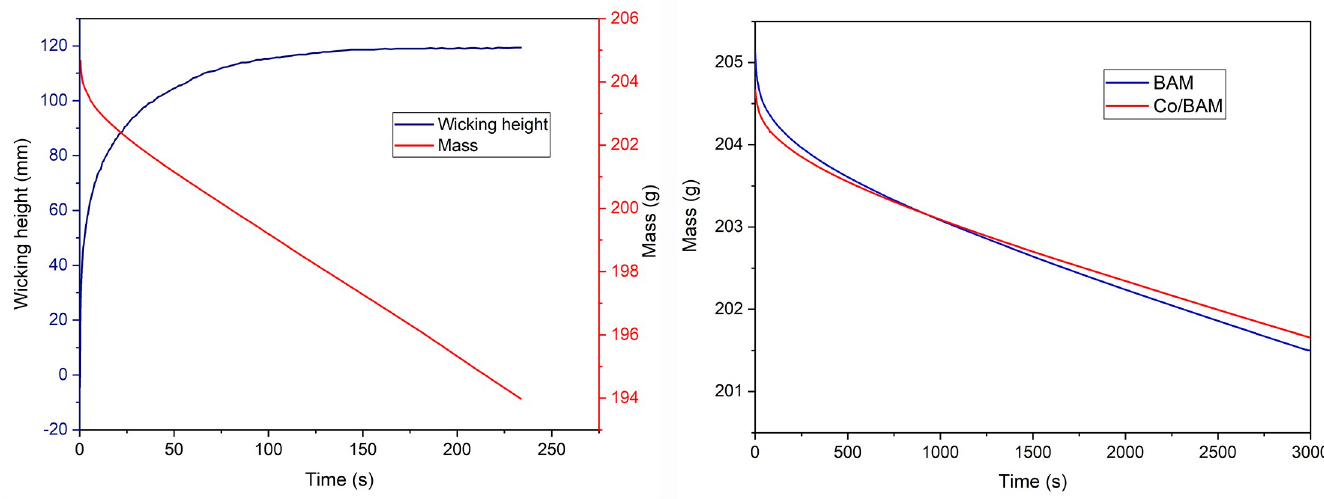
Fig 12. Example of a) determined wicking height of the hemp knitted fabric (5 cm with) and mass recorded b) comparison of mass decrease in vessel for untreated and treated fabric.